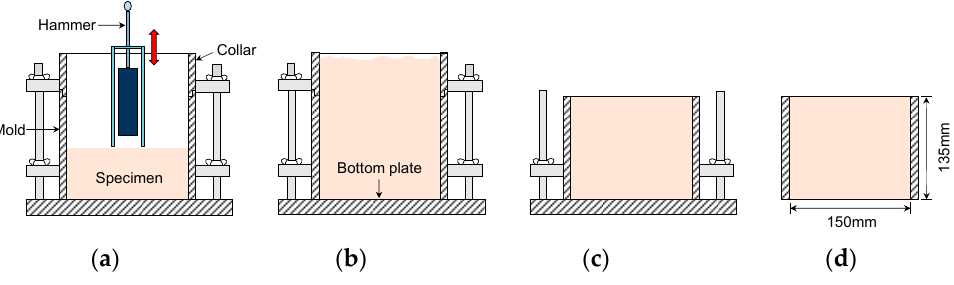
Figure 3. Procedure for compacting specimens: ( a ) compaction; ( b ) filling completion; ( c ) removal of collar; ( d ) removal of bottom plate. Table 2. Water content according to dry unit weight.